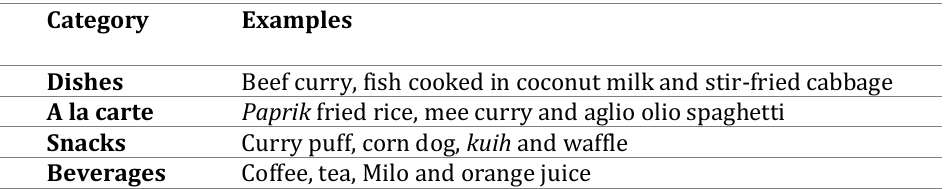
Table 1 : Categorisation of food and beverages sold in canteen and cafeterias.